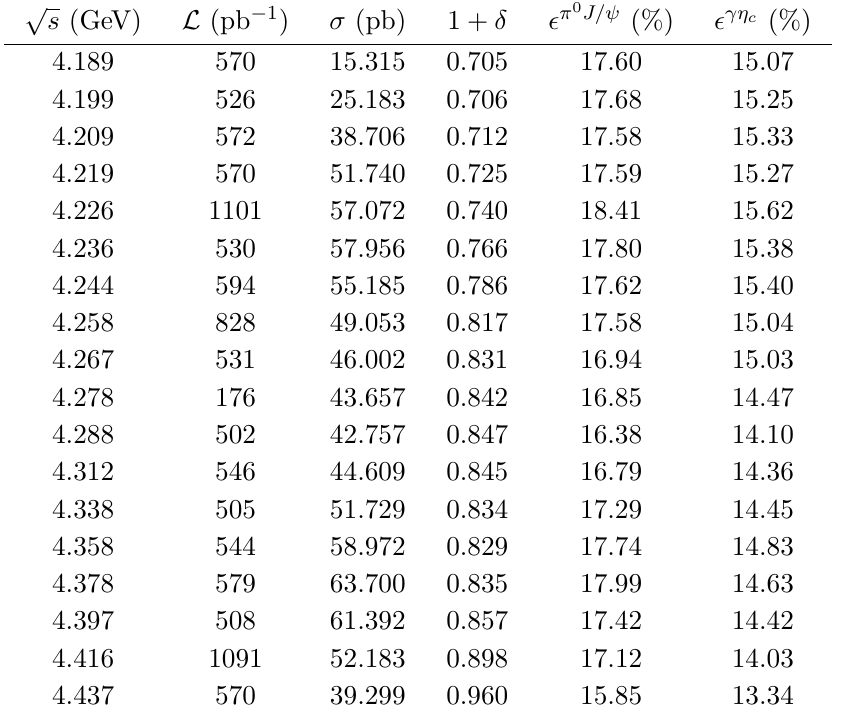
Table 1 . The luminosity L , cross section σ , radiative correction factor 1 + δ and efficiency (cid:15) at each √ center-of-mass energy s